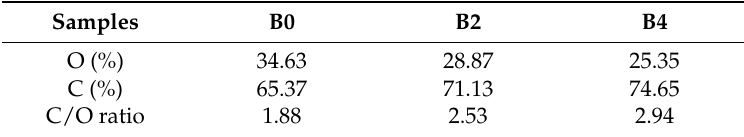
Figure 9. C1s spectra of unmodified (B0, a ) and modified (B2, b ; B4, c ) bagasse samples, and the general XPS spectra ( d ) of bagasse samples. Table 6. The elemental analysis of bagasse samples obtained from XPS spectra.